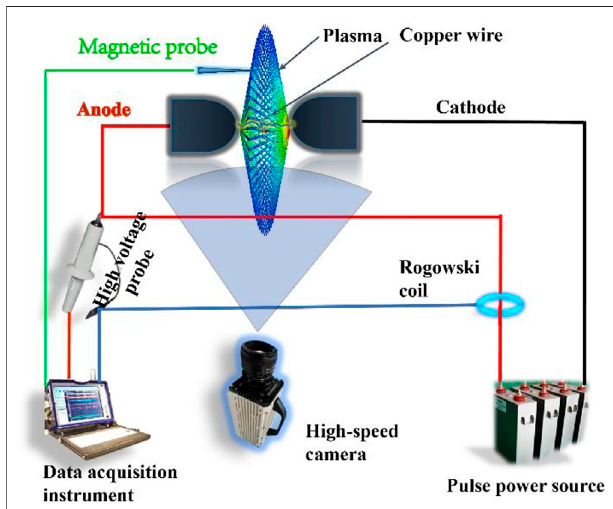
FIGURE 1 | Schematic diagram of the experiment